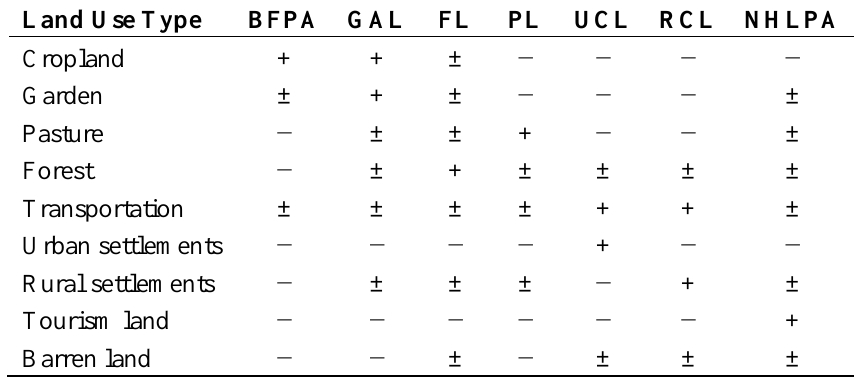
Table 2. The dominant, allowable, and prohibited land use types for each land use